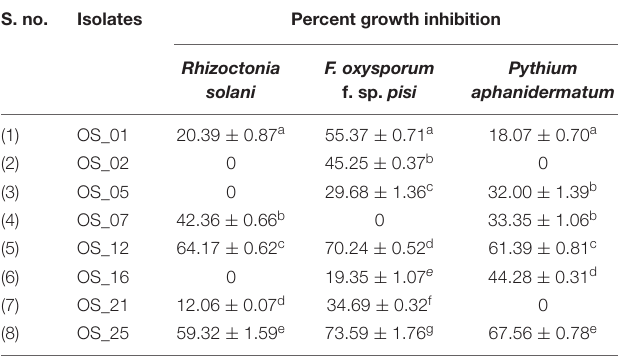
Plants in dual plate assay under in vitro experimental conditions. Data shown as percent of growth inhibition of mycelium of fungus by bacterial strains. Values represent mean values ± standard deviation (n = 3). Different minuscules indicate statistical difference (Turkey’s post test, P < 0.05) while same letters superscript are not significantly